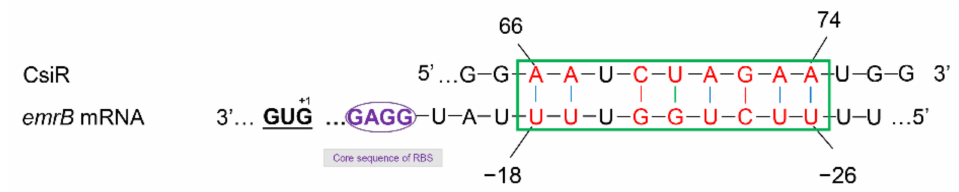
Figure 7. Base-pairing interaction between CsiR and emrB mRNA. The binding sites between CsiR and emrB mRNA are marked in red. The core sequence of RBS is marked in purple.